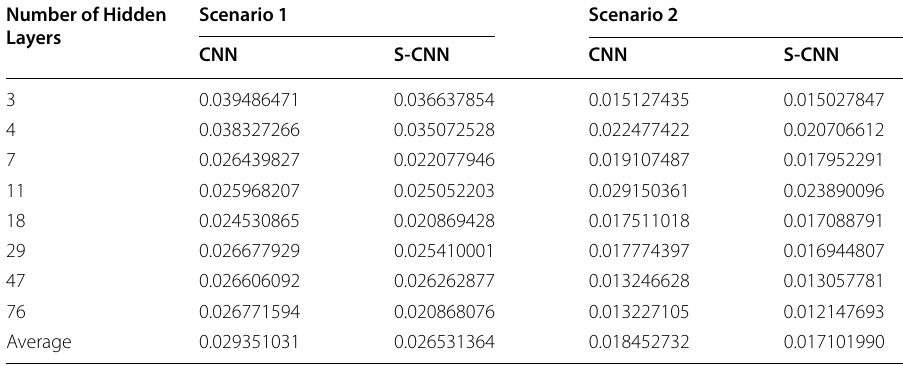
0.57) in all scenarios =